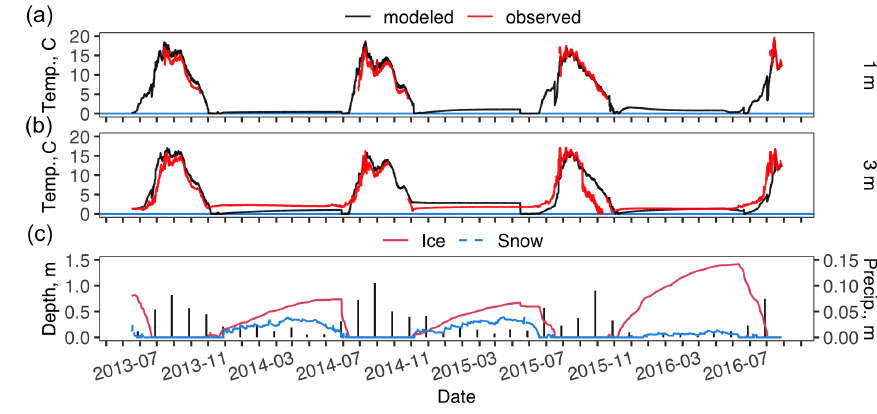
Figure 3. Toolik Lake modeled and observed lake water temperature at 1m (a) and 3m (b) and modeled lake ice depth, lake snow depth, and measured monthly precipitation (vertical black bars) (c) . Missing observed data in (a) and (b) are due to seasonal placement and removal of the temperature sensors; see Sect. 2 for details. The y axis of panel (a) is limited to water temperatures > 0 ◦ C as the LAKE model water temperature is limited to > 0 ◦